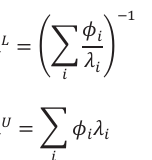
Figure 1: Wiener model scheme (Wiener, 1912): (a) series model - lower limit; (b) parallel model - upper